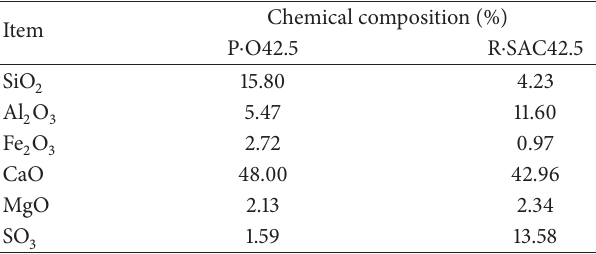
Figure 1: XRD analysis of NS materials.